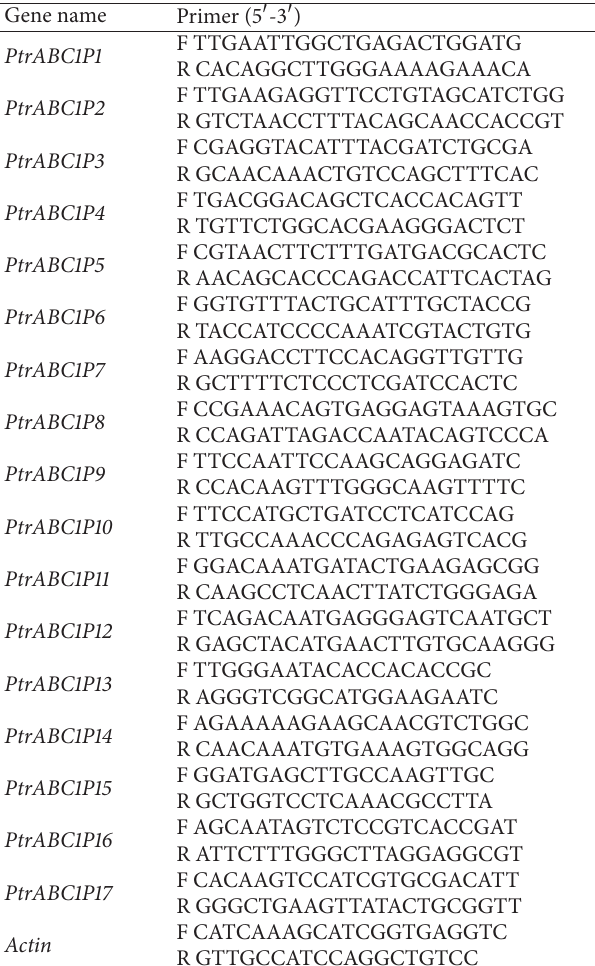
Table 4: Primers for the 17 ABC1 genes and Actin used in qRT-PCR. F represents forward primer while R represents reverse primer. All primers are listed in the 5 󸀠 -3 󸀠